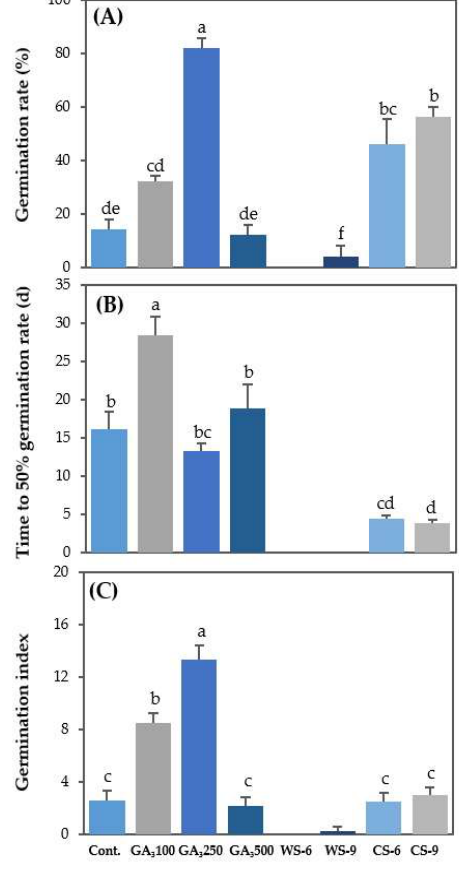
Figure 3. Comparison of GA 3 and stratification (CS and WS) treatments on the germination vigor of L. coreana seeds under optimum germination conditions (25/15 °C, 12 /12 h [light/dark]). ( A ) Germi- nation rate (GR, %); ( B ) the time to achieve a 50% germination rate (T 50 , days); ( C ) Germination index (GI). Data were analyzed by Tukey’s honestly significant difference test. Bars indicate the standard error ( n = 5). Mean values sharing the same letters do not differ significantly ( p < 0.05).